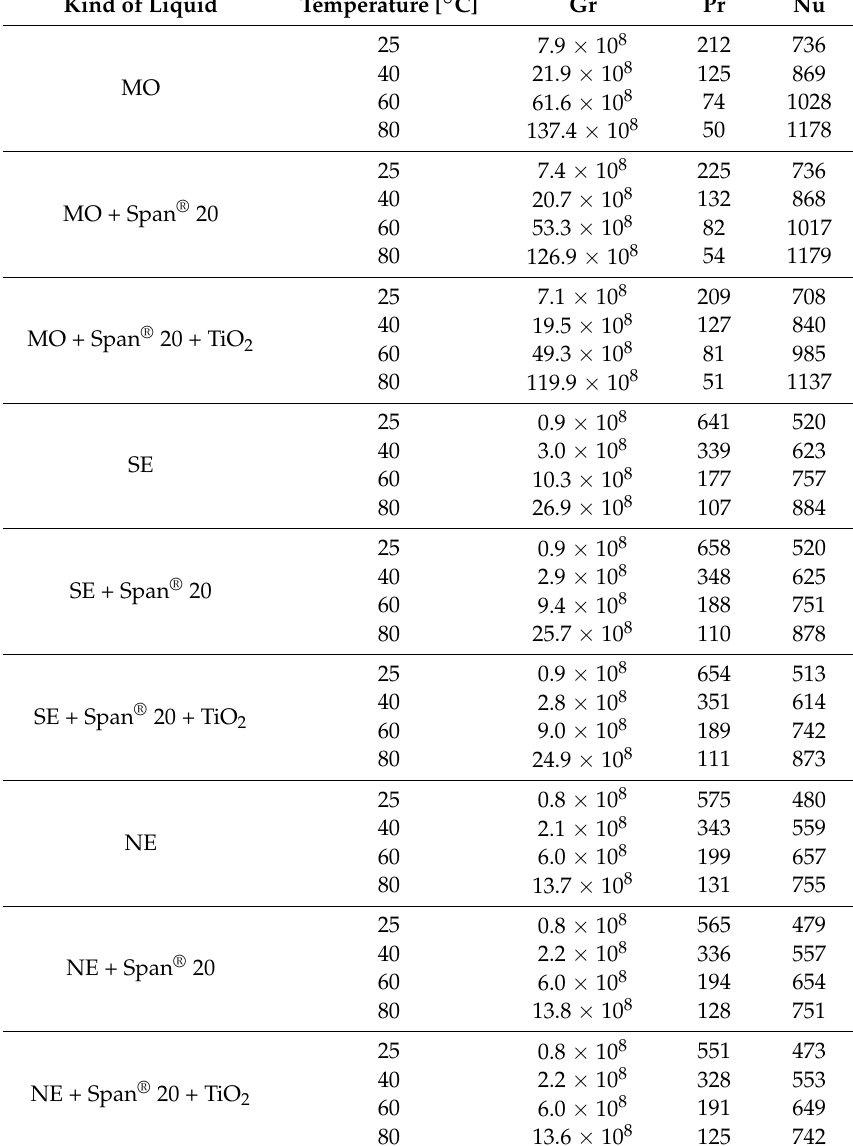
Table 7. Calculation results of Grashof, Prandtl, and Nusselt numbers of pure electro-insulating liquids and nanofluids based on surfactant Span ® 20 and titanium dioxide (TiO 2